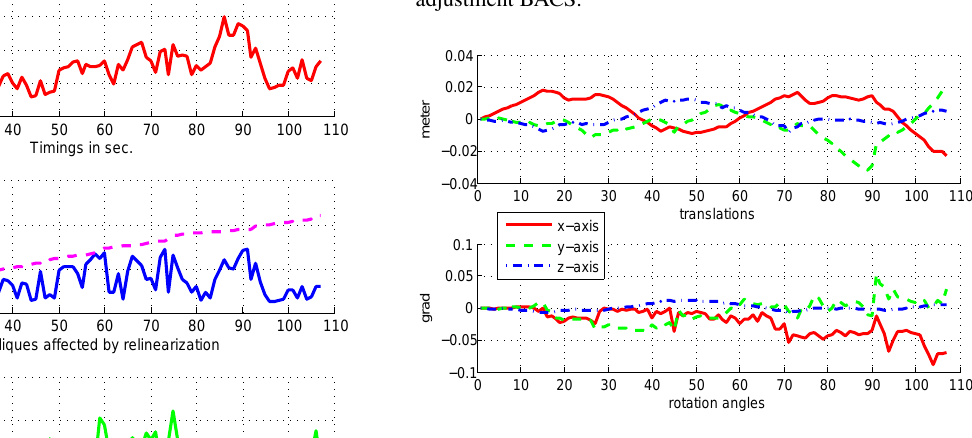
Figure 9: Deviations between the estimated rotation angles and translations of BACS and iSAM2 on all set of keyframes. The z-axis points in flight direction, the x-axis points upwards and the y-axis is orthogonal to